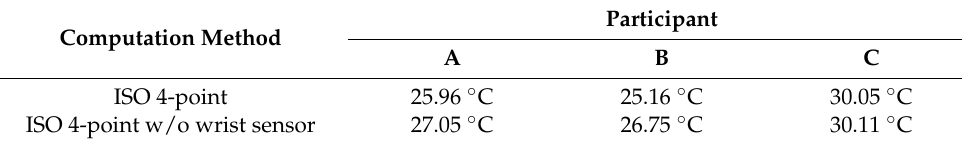
Table 6. Skin temperature measurements at thermal comfort.